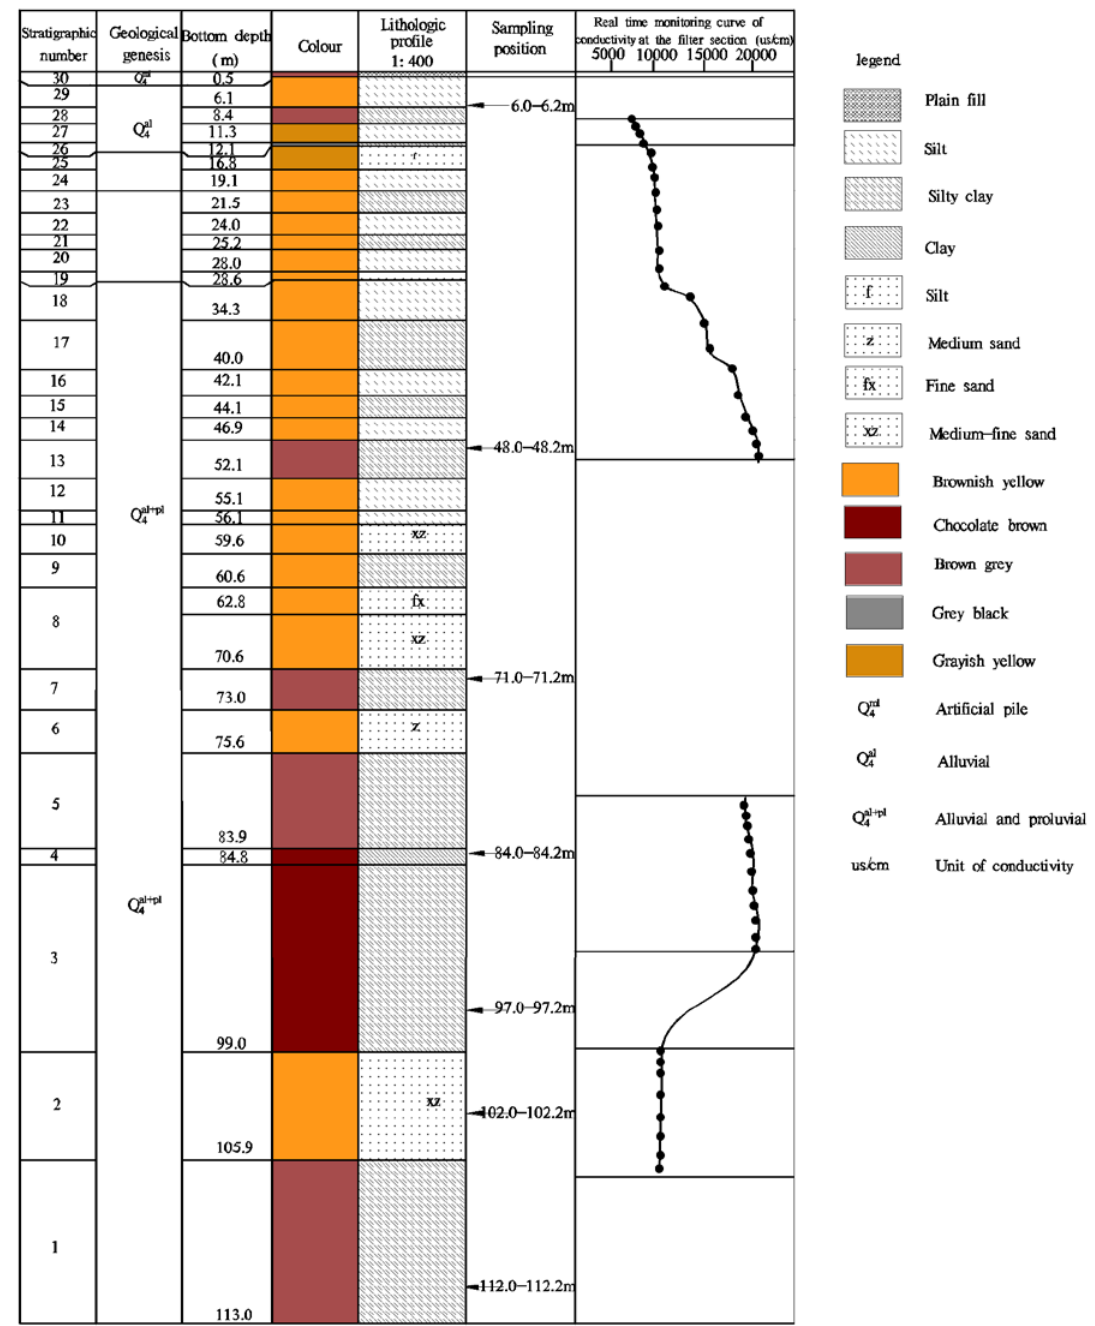
Figure 2. Stratigraphic histogram for depths of 0–113 m.